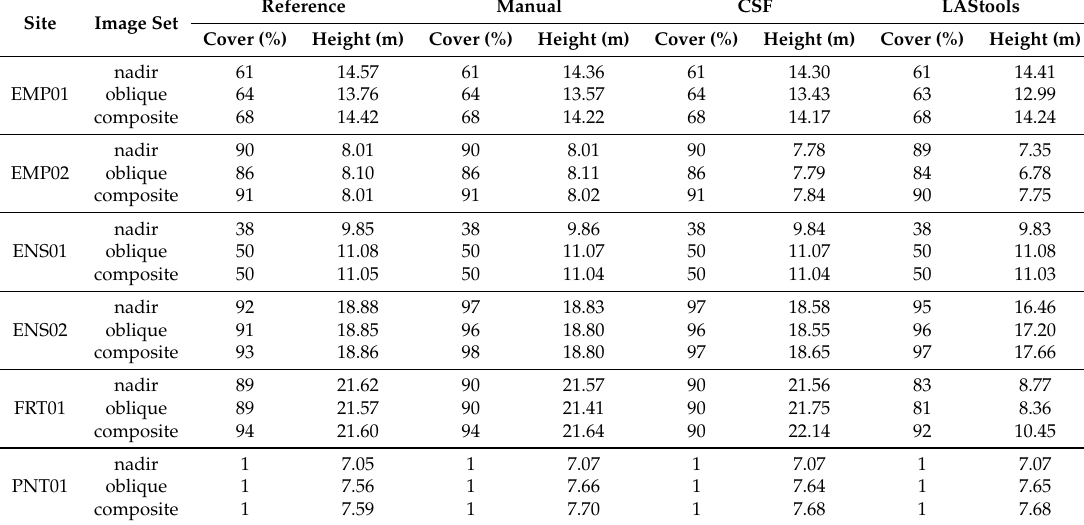
Table 6. Canopy cover and mean canopy height estimated under each image network and ground point